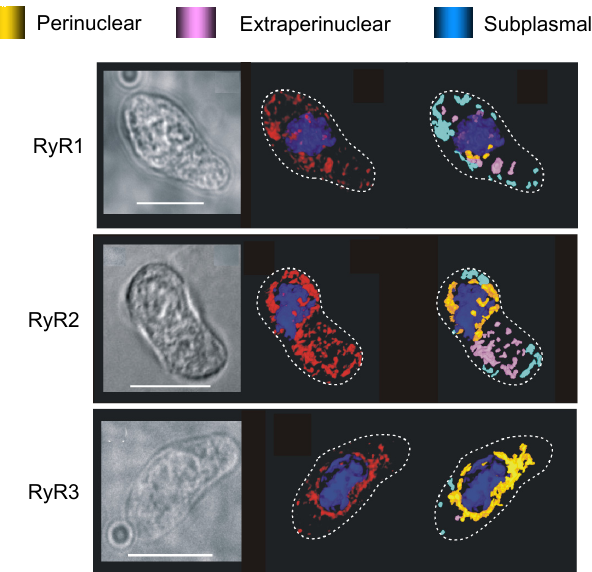
Figure 8. Example cells showing labelling for RyR1 ( upper panels ), RyR2 ( middle panels ) and RyR3 ( lower panels ) in pulmonary arterial myocytes. In each case, from left to right, a bright field image, 3D reconstruction and 3D digital representation of labelling colour coded by region of the cell are shown. Nucleus identified by DAPI labelling (navy blue). Scale bars, 10 μ m.